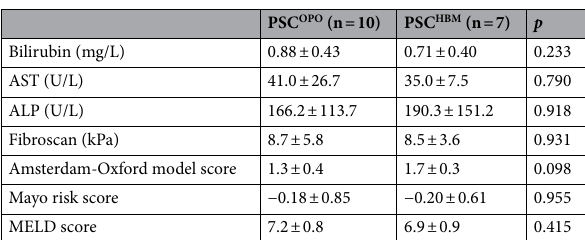
Table 2. PSC-specific parameters in PSC OPO and PSC HBM